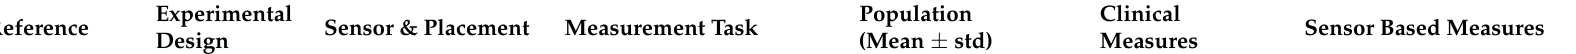
Table A1. Continuous recording in the hospital or during